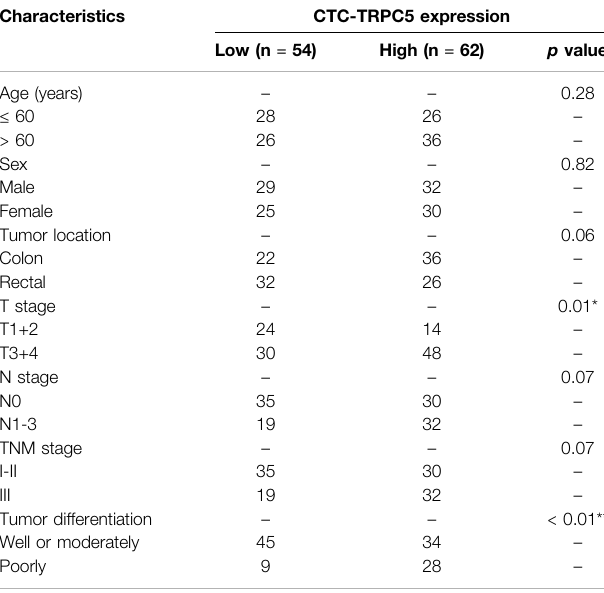
TABLE 1 | Clinical and tumor characteristics of the 116 CRC patients. TABLE 2 | Characteristics of CRC patients according to CTC-TRPC5